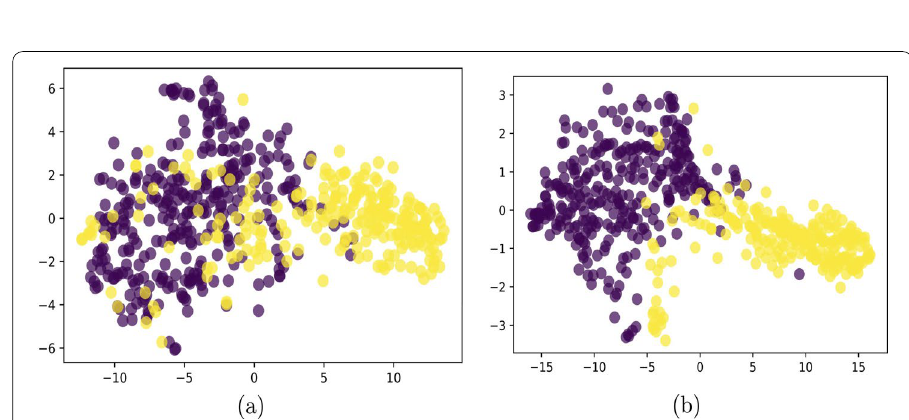
Fig. 4 t -SNE 2D visualization of the entity embeddings learned from ML-GCN over Koumbia -2: a after one epoch, b after 1000